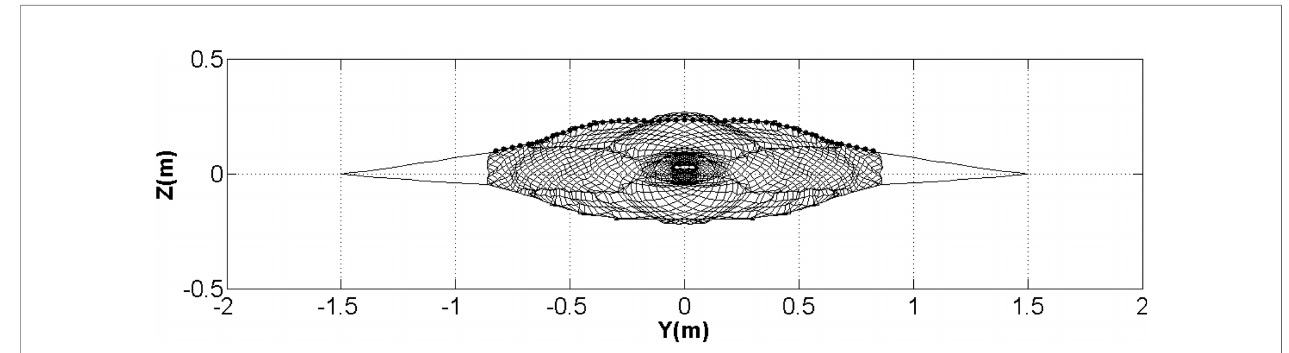
FIGURE 9 | Shape of trawl mouth from the numerical simulation at the towing speed of 1.43 kn in model tests.